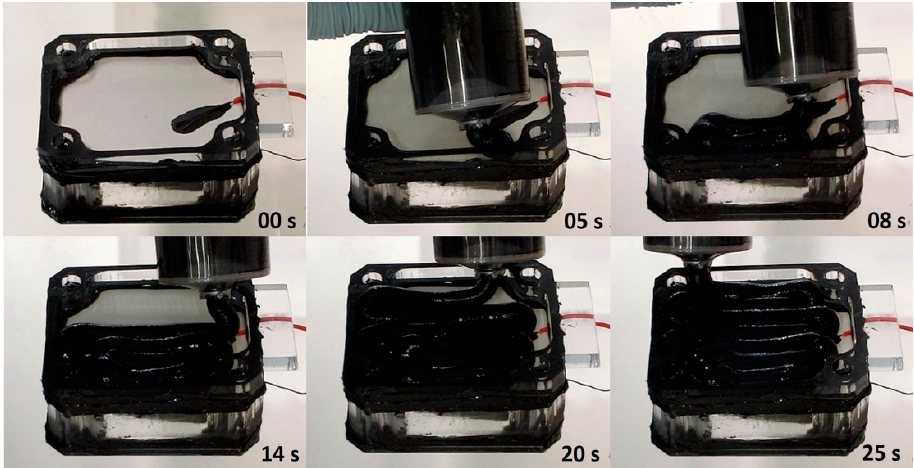
Figure 7. Time-lapse photography of the manual extrusion of the PTFE-free/alginate-based cathode electrode on the membrane of an assembled MFC. Molecules 2020 , 25 , x FOR PEER REVIEW